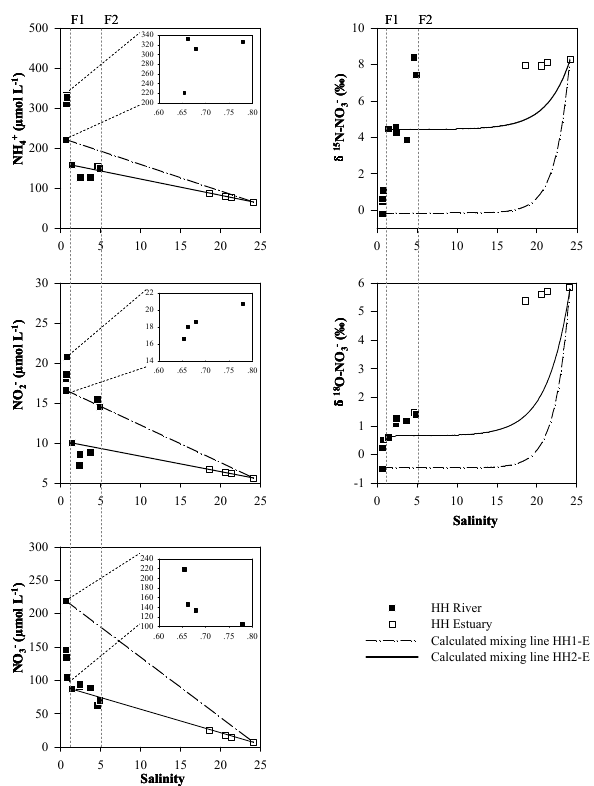
) concentrations and isotopic Figure 3. DIN (NH + , NO − , NO − 4 2 3 748 composition of NO − versus salinity in the HH River and the HH 3 Estuary. HH1-E represents the calculated mixing line between the initial upstream and the estuary; HH2-E represents the calculated mixing line between the floodgate F1 and the estuary; F represents